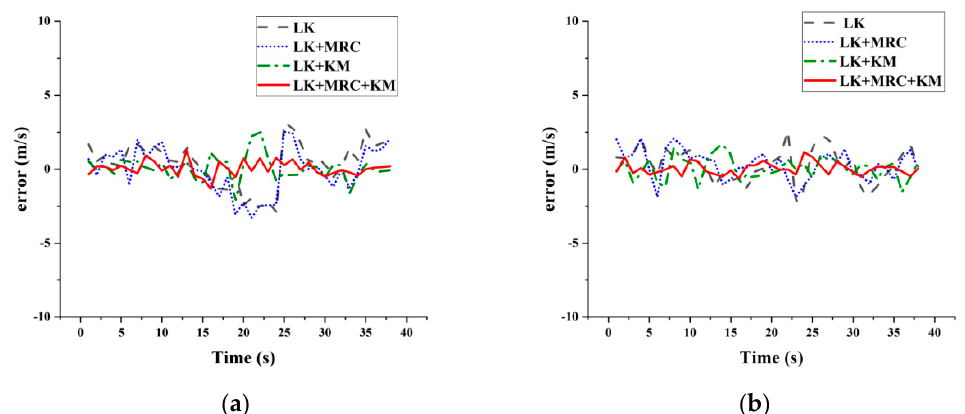
Figure 9. ( a ) Velocity error in X direction of experiment 1; ( b ) velocity error in Y direction of experiment 1. Table 4. Velocity errors of four algorithms in the Y direction.